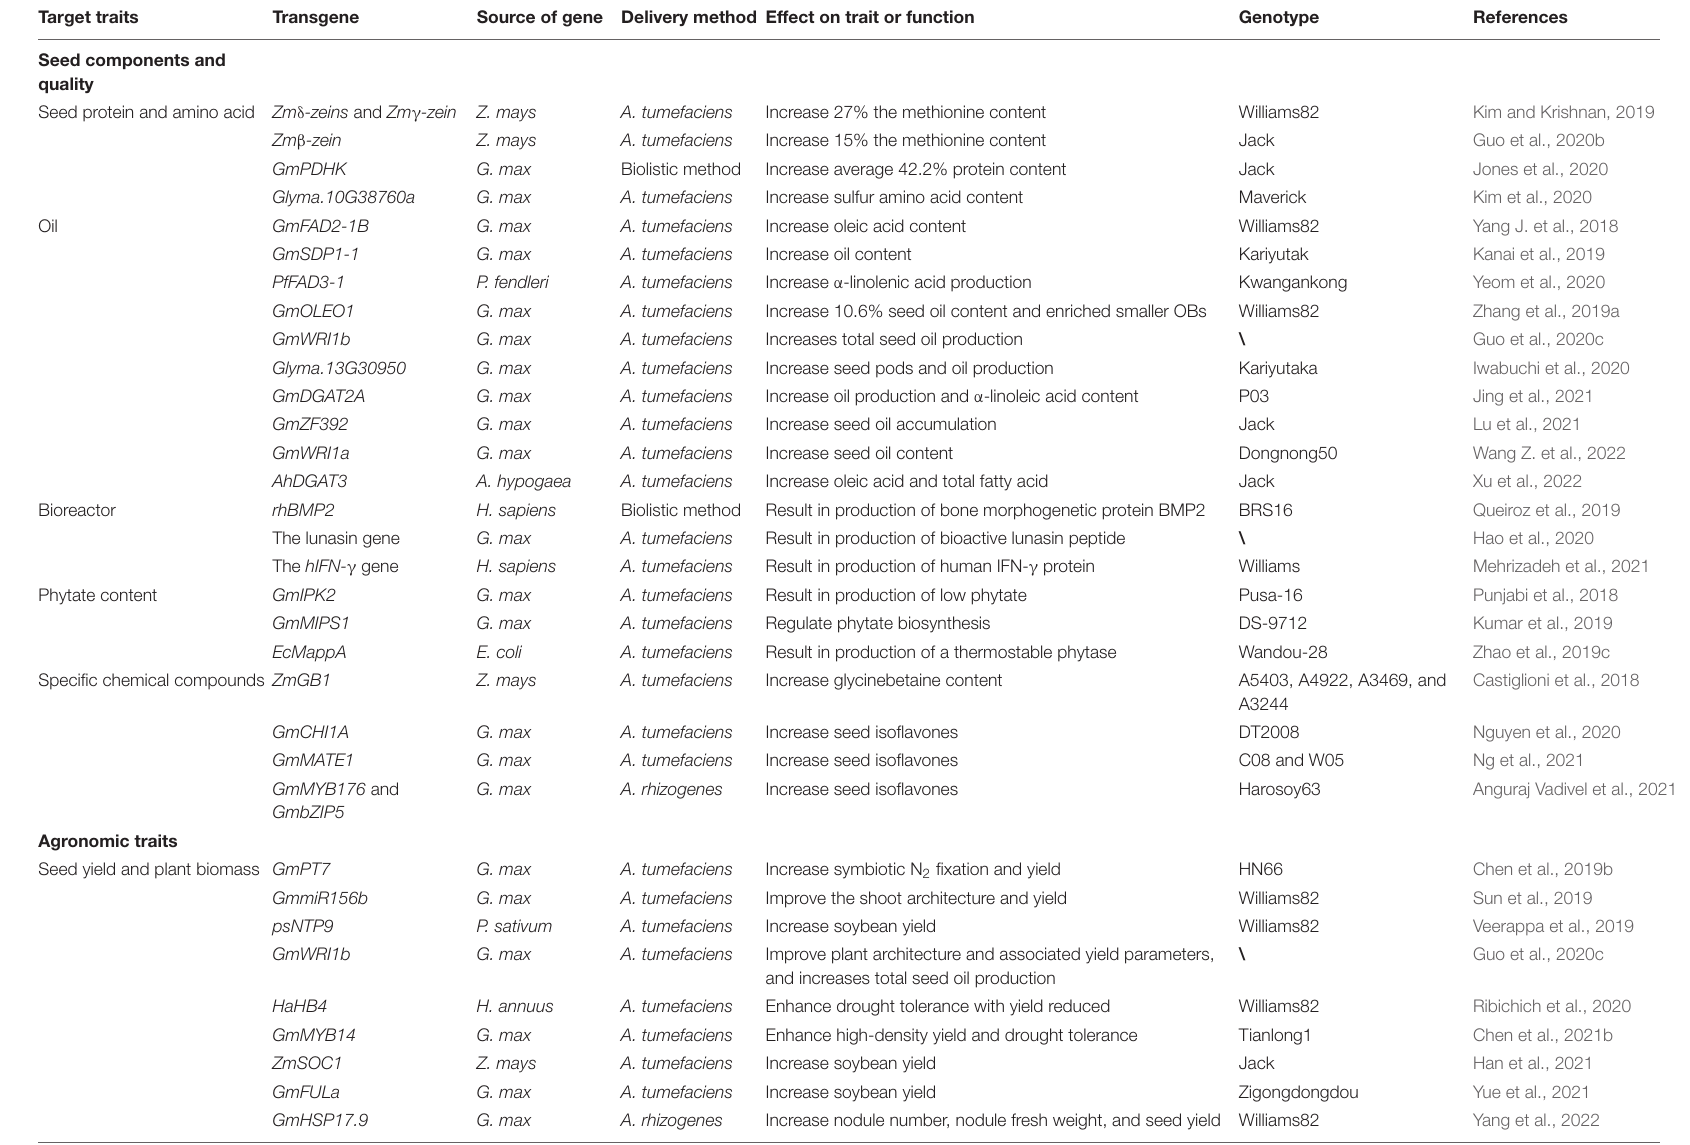
TABLE 2 | Summary of transgenic approaches for soybean trait improvement and functional genomics in the last 5